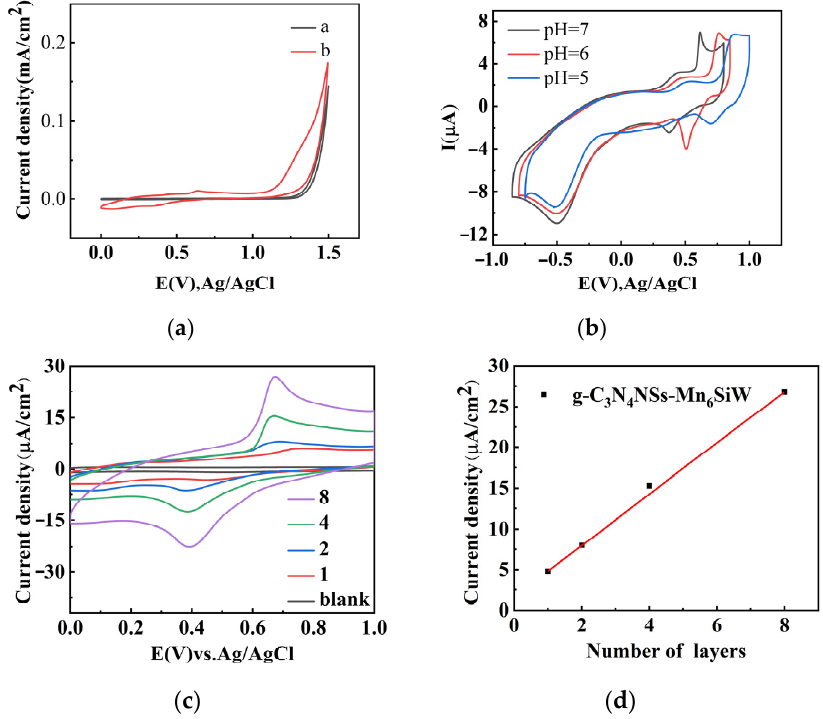
Figure 6. ( a ) Cyclic voltammogram (CV) curves of Mn 6 SiW (0.6mM, curve b) and blank solution (curve a) in NaAc/HAc buffer (0.5 M, pH = 7.0). ( b ) CV curves of Mn 6 SiW in NaAc/HAc buffer (0.5 M) at different pH (5/6/7); ( c ) CV curves of the film (g-C 3 N 4 NSs/Mn 6 SiW)n in NaAc/HAc buffer (0.5 M, pH 7), n = 1, 2, 4, 8; at 50 mV / s; ( d ) the relationship between the oxidation peak current of Mn II / IV and the number of assembled layers.